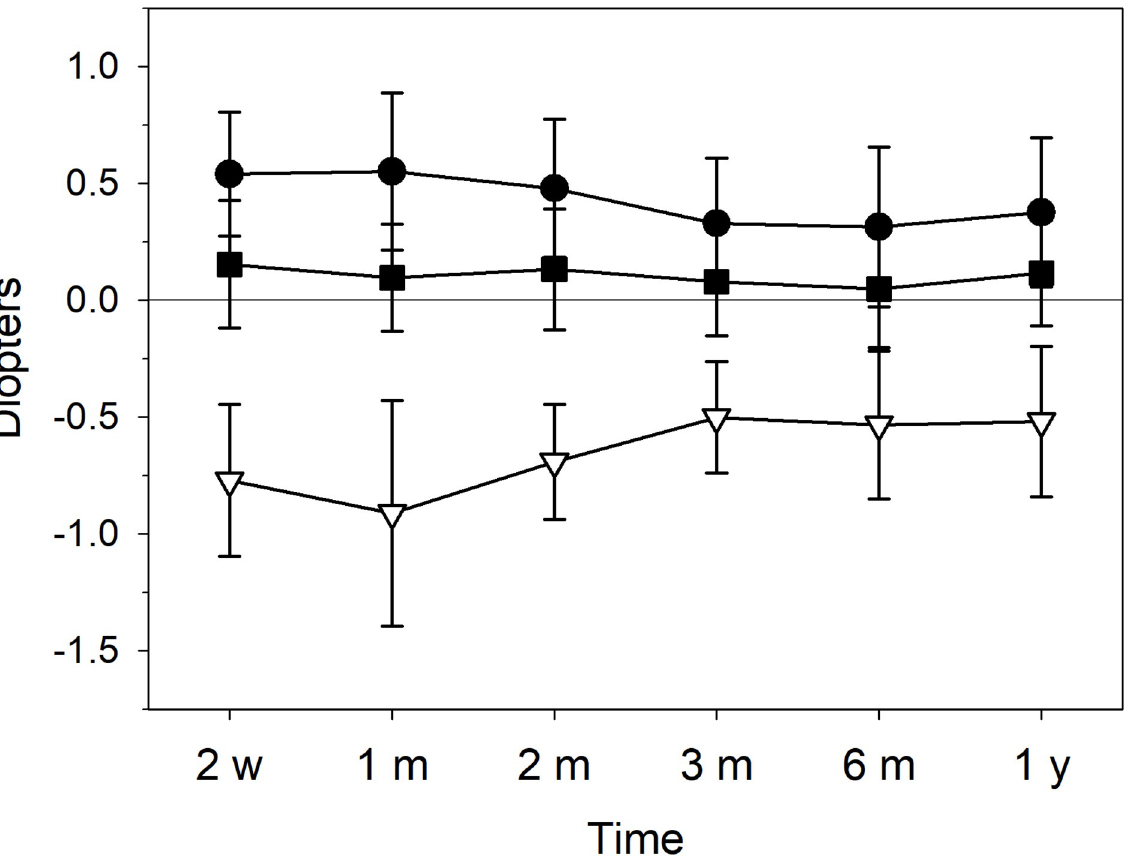
Fig 2. Mean values of induced refraction components of the cornea: sphere (circles), cylinder (triangles) and spherical equivalent (squares), at all follow-ups.